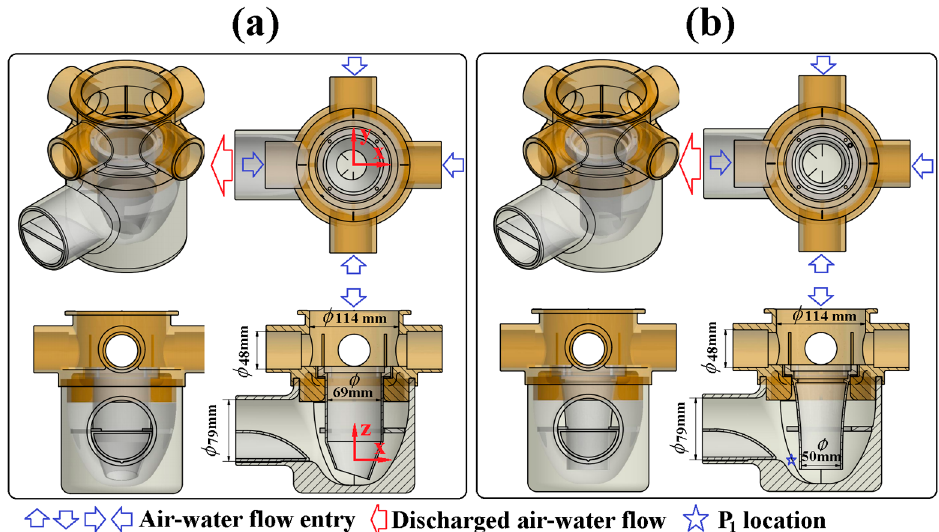
Figure 1. Test gullies with the convergent nozzle of: ( a ) beveled discharge; and ( b ) vertical discharge. Table 1. Experimental and numerical test conditions.